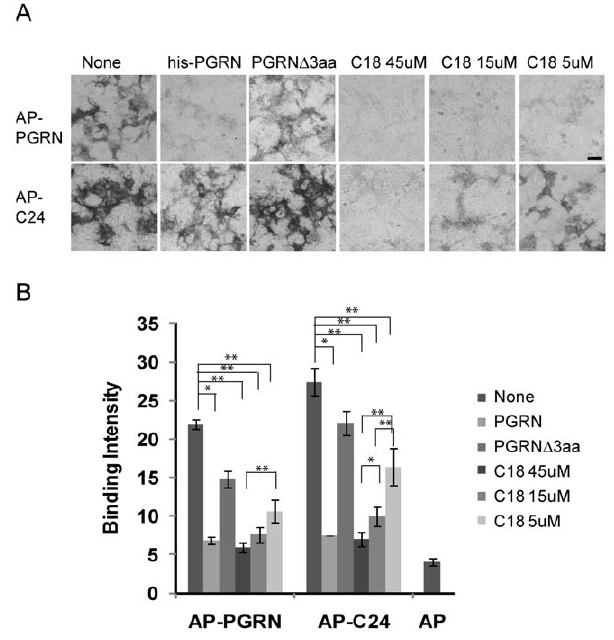
Figure 3. Progranulin C-terminal peptide displaces progranulin binding to sortilin. ( A ) Alkaline phosphatase fused full length PGRN and C24 binding to sortilin can be displaced by purified recombinant his-PGRN, C18 peptide (EAPRWDAPLRDPALRQLL) but not by his- PGRN D 3aa. Sortilin expressing COS-7 cells were incubated with 150 nM purified his-PGRN, his-PGRN D 3aa or C18 peptide of indicated concentrations for 1 hour before adding 10 nM of AP-PGRN or AP-C24. ( B ) Quantification of binding intensity for experiments in (A) using the ImageXpress system. Scale bar=100 m m. *, p , 0.05;**, p , 0.01, n=3–6, paired Student’s